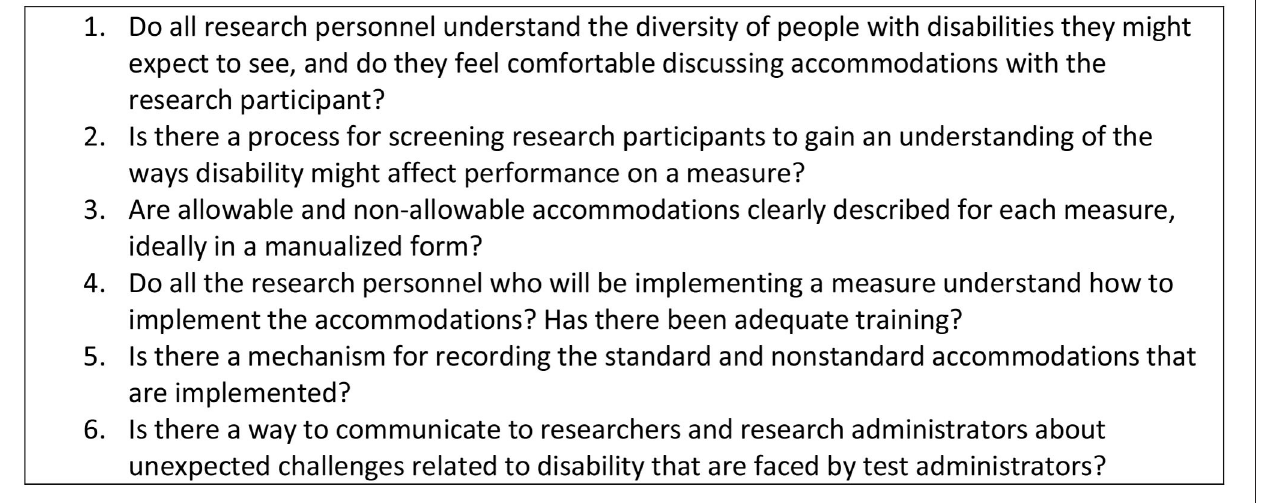
FIGURE 5 | Accessibility questions for test